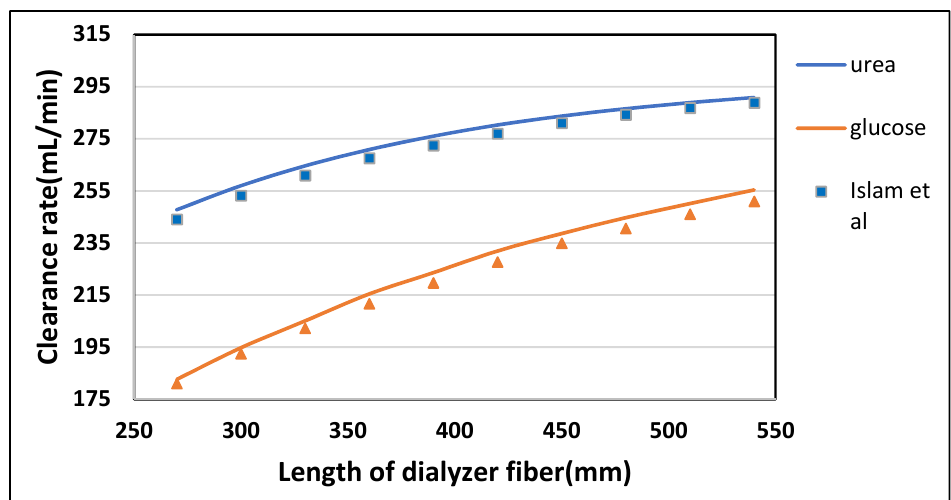
Figure 9. The clearance rate of low molecular weight solutes (urea, glucose) plotted against varying length of the dialyzer at Q B = 300 mL/min and Q D = 500 mL/min.